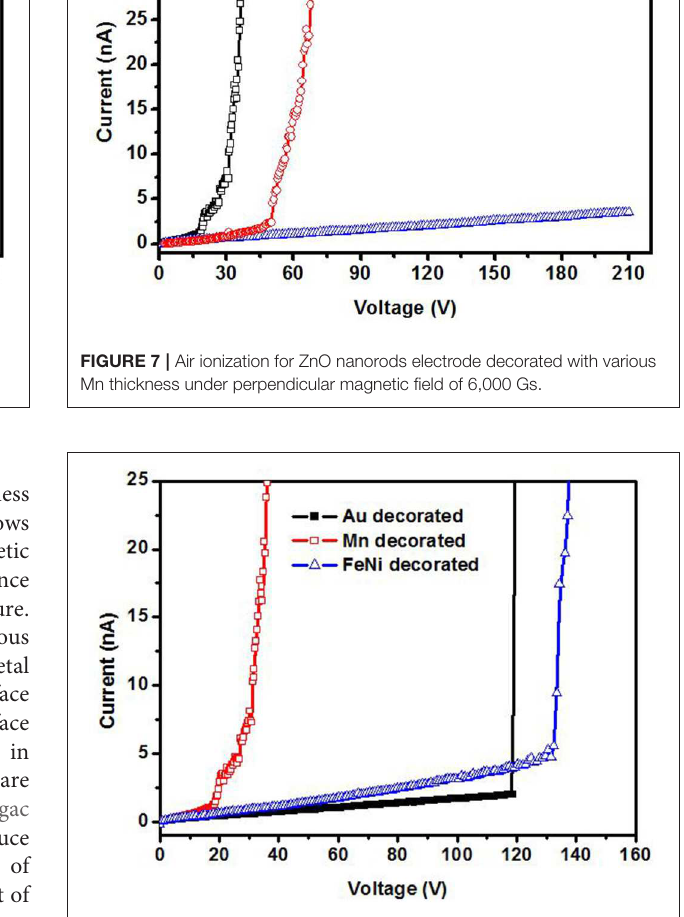
FIGURE 8 | Air ionization for various metal decorated ZnO nanorods under perpendicular magnetic field (6,000